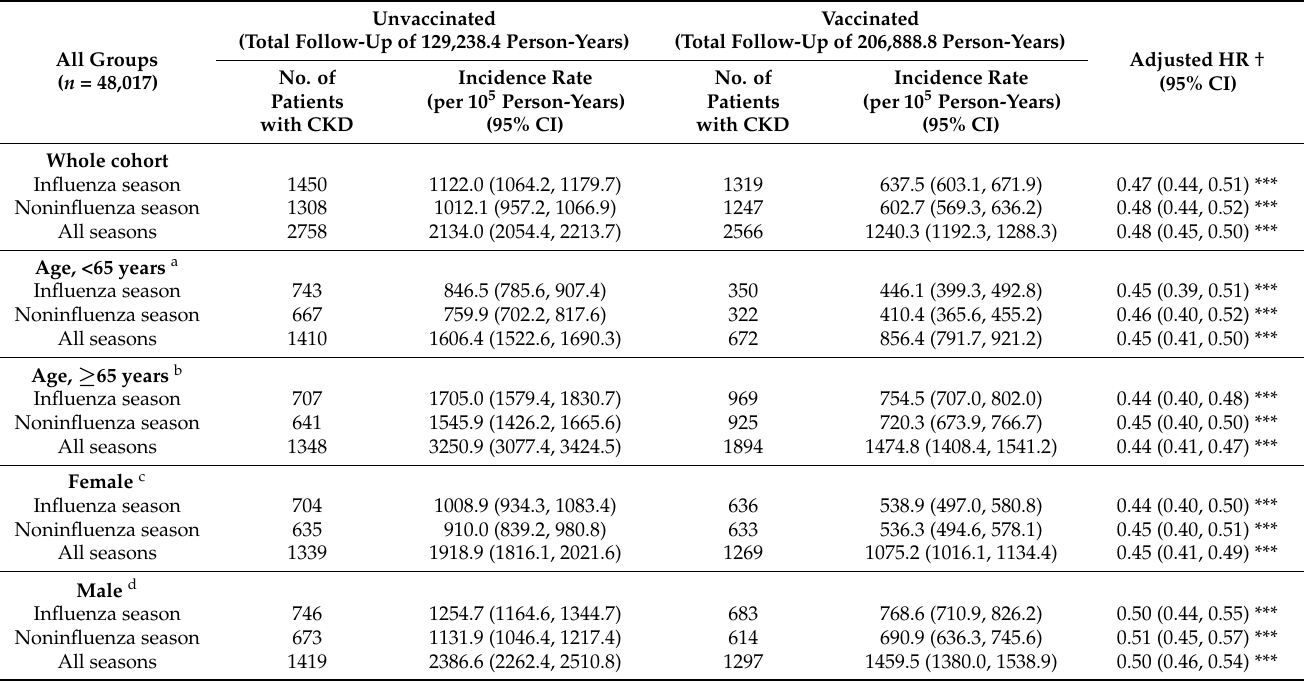
Table 2. Risk of CKD in the Unvaccinated and Vaccinated Patients in the Study Cohort. Unvaccinated (Total Follow-Up of 129,238.4 Person-Years)